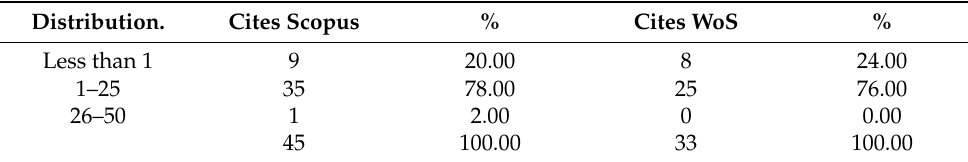
Table 2. Distribution of citations by